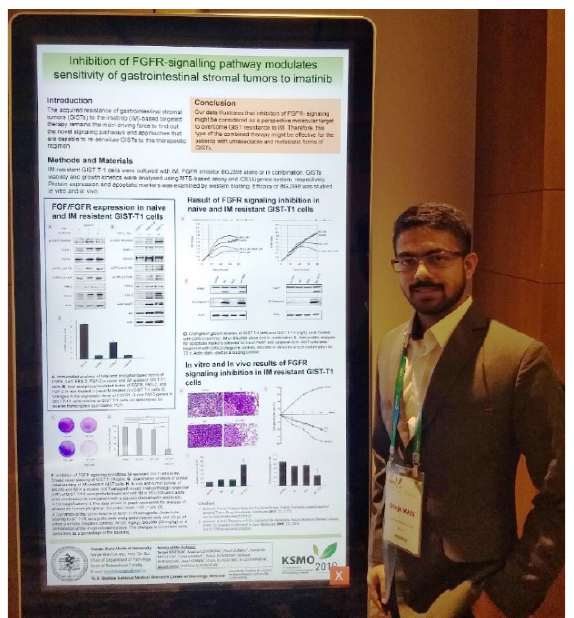
Figure 1 . Digital Poster Presentation at KSMO 2019 International Conference, Seoul,